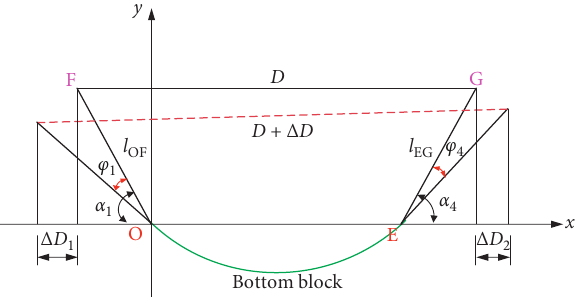
Figure 7: Geometric relationship between horizontal diameter convergence and segment rotation. Points F and G are the mea- suring points of horizontal diameter